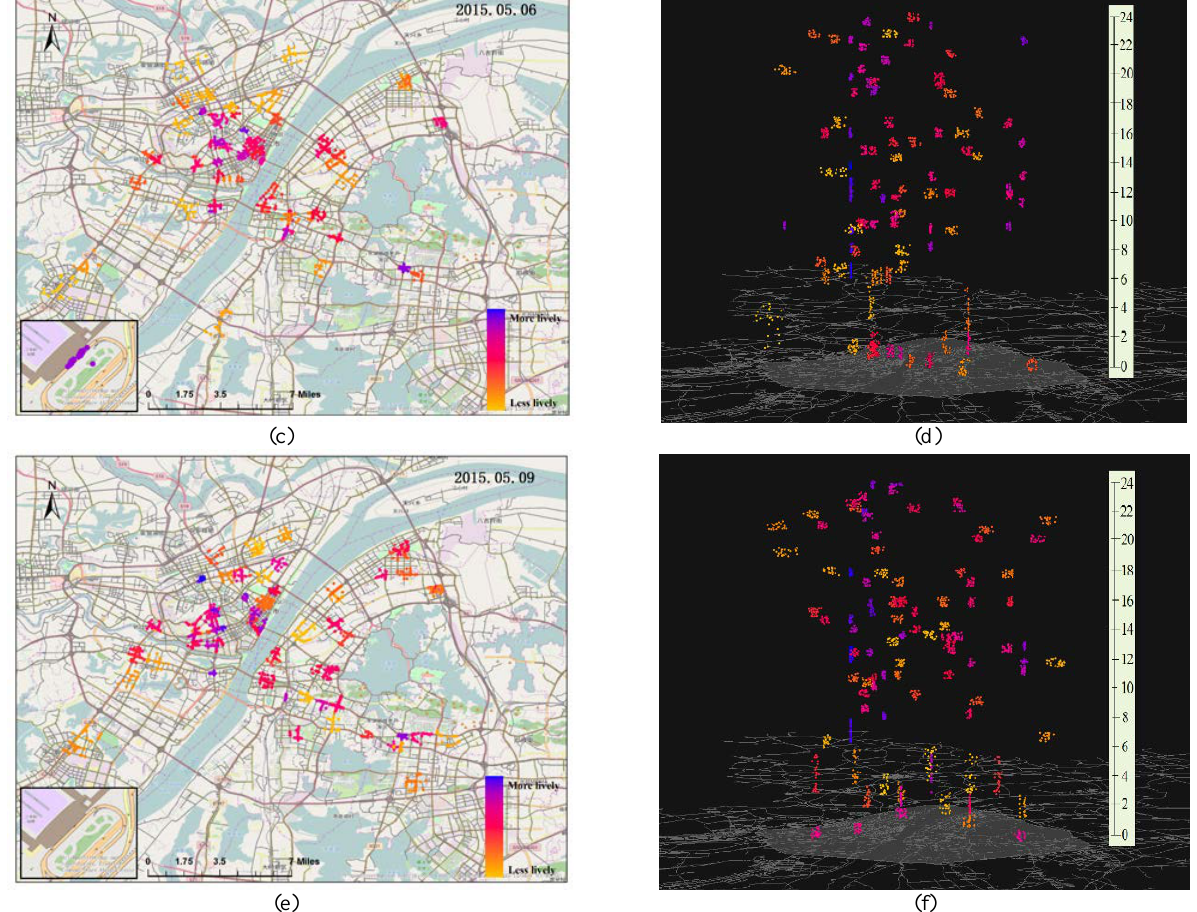
Figure 9. Hotspots detection results. (a) The top-view of hotspots in May 1 st , (b) 3D visualization of hotspot in May 1 st , (c) the top- view of hotspots in May 6 th , (d) 3D visualization of hotspot in May 6 th , (e) the top-view of hotspots in May 9 th , (f) 3D visualization of hotspot in May 9 th